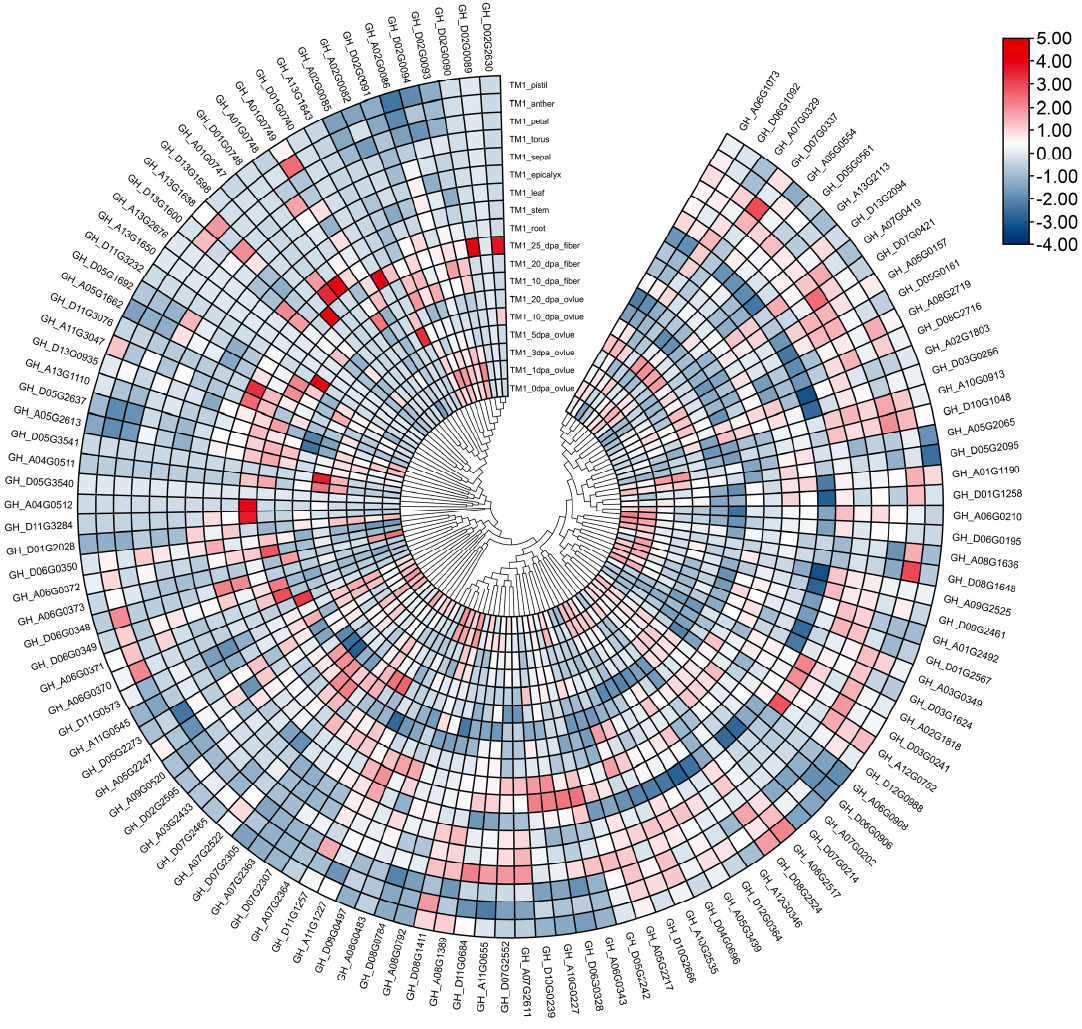
Figure 7. Expression pattern analysis of GhFBXL genes. This website’s (http://cotton.zju.edu.cn/, accessed on 15 September 2021) RNA—seq data generated heat maps, and color scale as shown in the figure above on the right